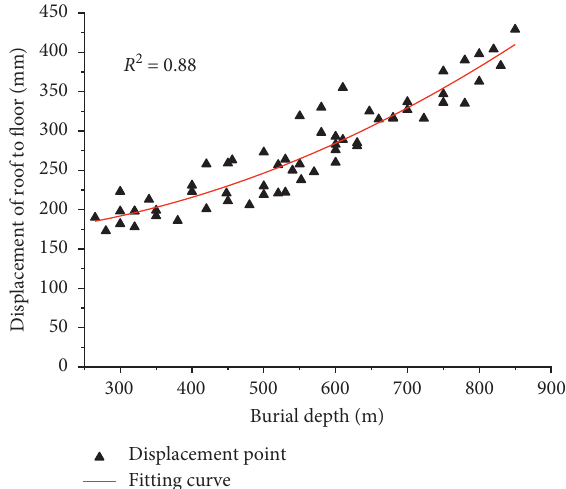
Figure 21: 10 m away from the working face.